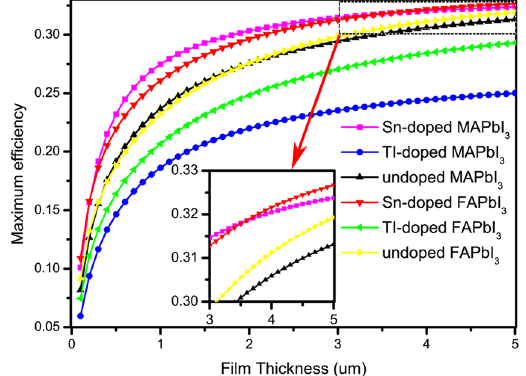
Figure 5. The calculated maximum efficiencies of the cation-doped and undoped MA(FA)PbI 3 . The violet, blue, black, red, green, and yellow lines represent the maximum efficiencies of the Sn-doped MAPbI 3 , TI-doped MAPbI 3 , un-doped MAPbI 3 , Sn-doped FAPbI 3 , TI-doped MAPbI 3 and un-doped MAPbI 3 ,